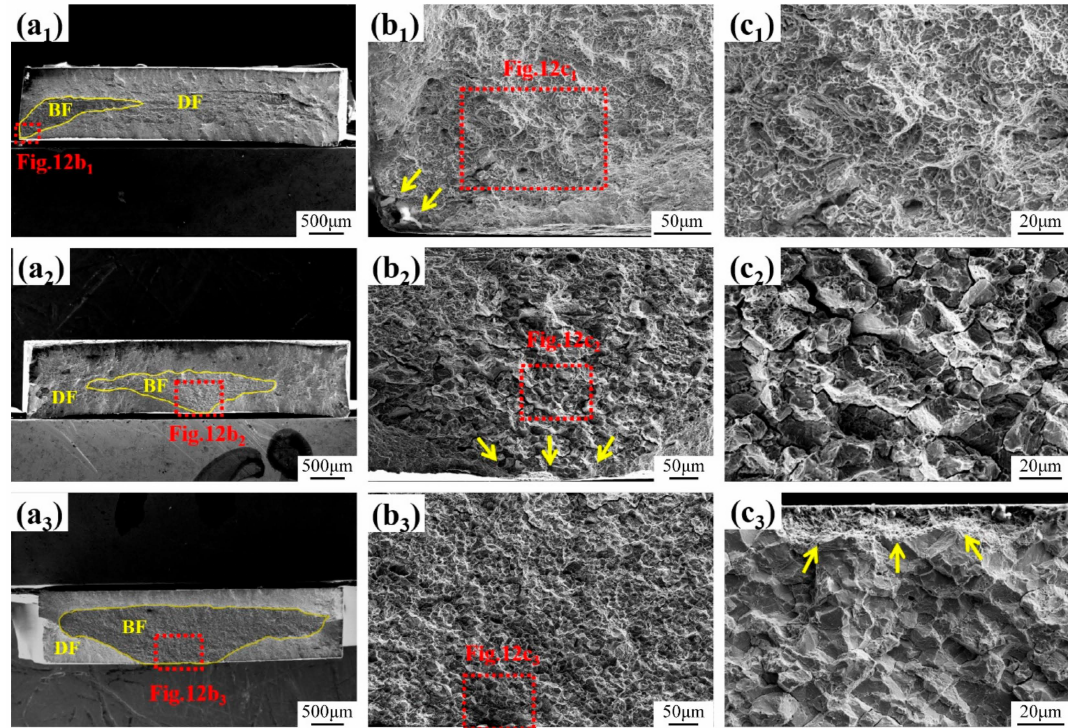
Figure 12. SEM images of fracture surface of specimens with in-situ immersed SSRT under varying strain rates: ( a 1 – c 1 ) 1 × 10 − 4 s − 1 , ( a 2 – c 2 ) 5 × 10 − 5 s − 1 , and ( a 3 – c 3 ) 1 × 10 − 6 s − 1 . The yellow solid lines indicate the boundaries between the brittle fractured region (BF) and the ductile fractured region (DF). The yellow arrows indicate the fracture origin sites of the